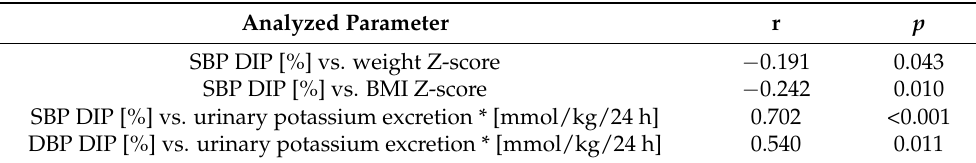
Table 5. Significant correlations of clinical and biochemical parameters with dipping status (continu- ous variable) in patients with primary hypertension.